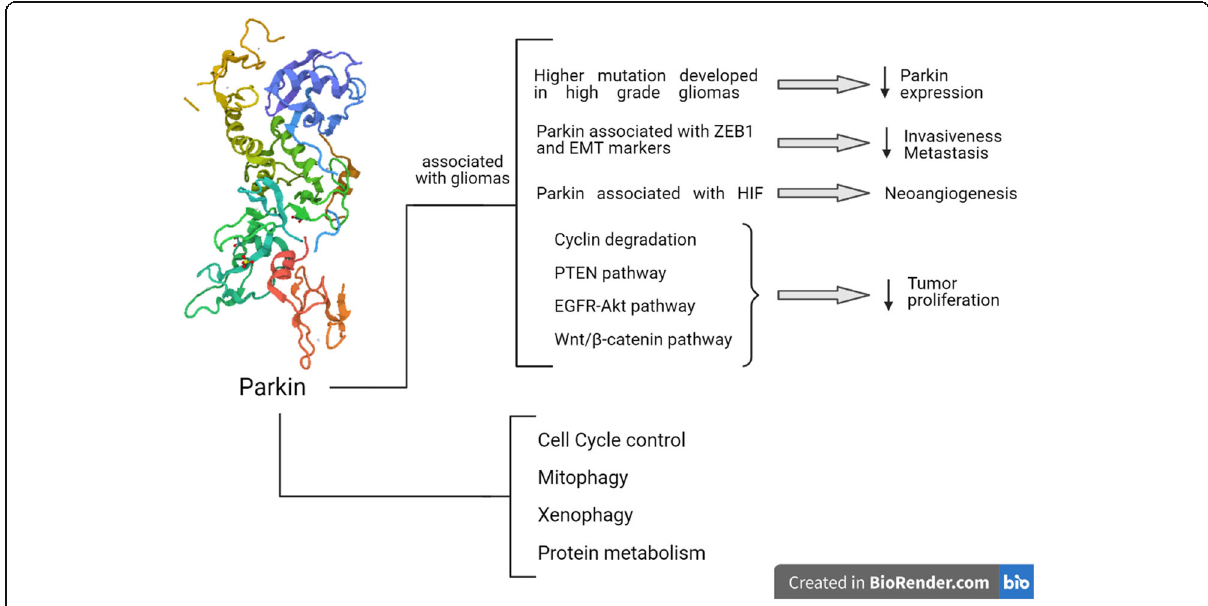
Fig. 2 Parkin molecular interactions and its effects on